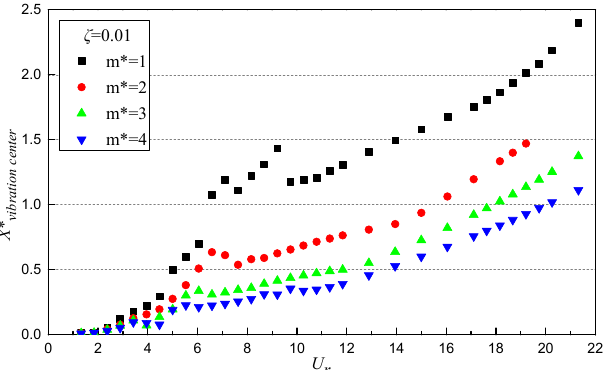
Figure 10. Variation in Ur in streamwise direction equilibrium position with different mass ratios.